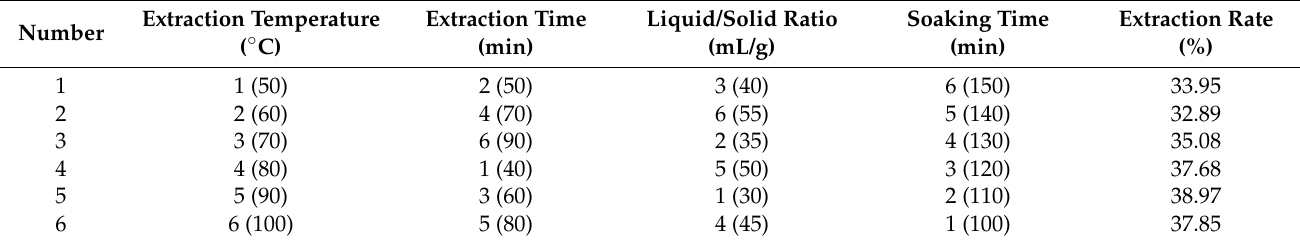
Table 1. Uniform design and test results.